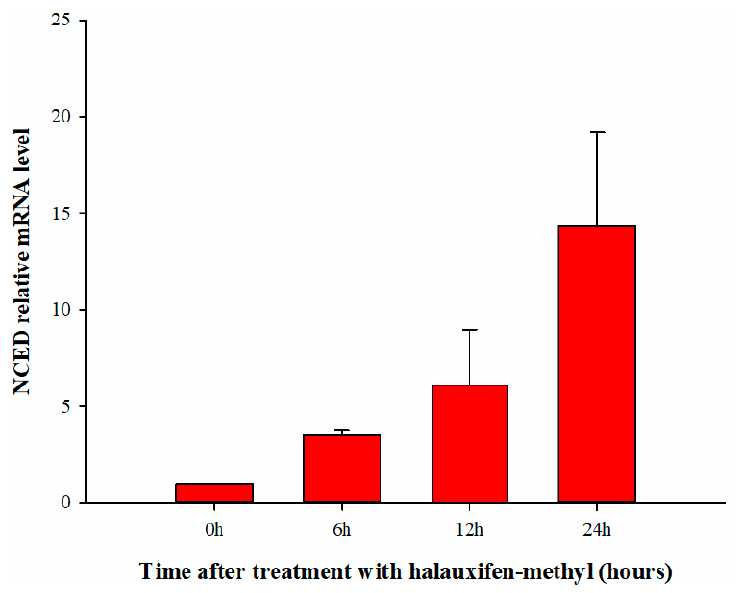
Figure 6. The GaNCED1 gene expression patterns in Galium aparine at 0, 6, 12, and 24 h after treatment with 5 μ M of halauxifen-methyl. Vertical bars represent the standard errors of the means.